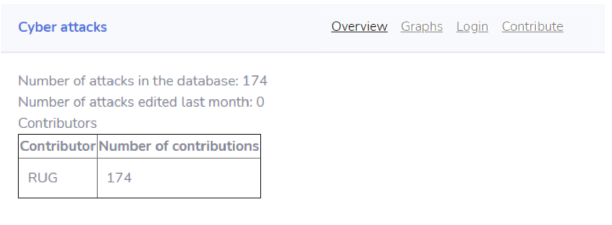
Figure 1. The summary of the exiting large-scale data set is displayed at the top-left corner of the overview page.